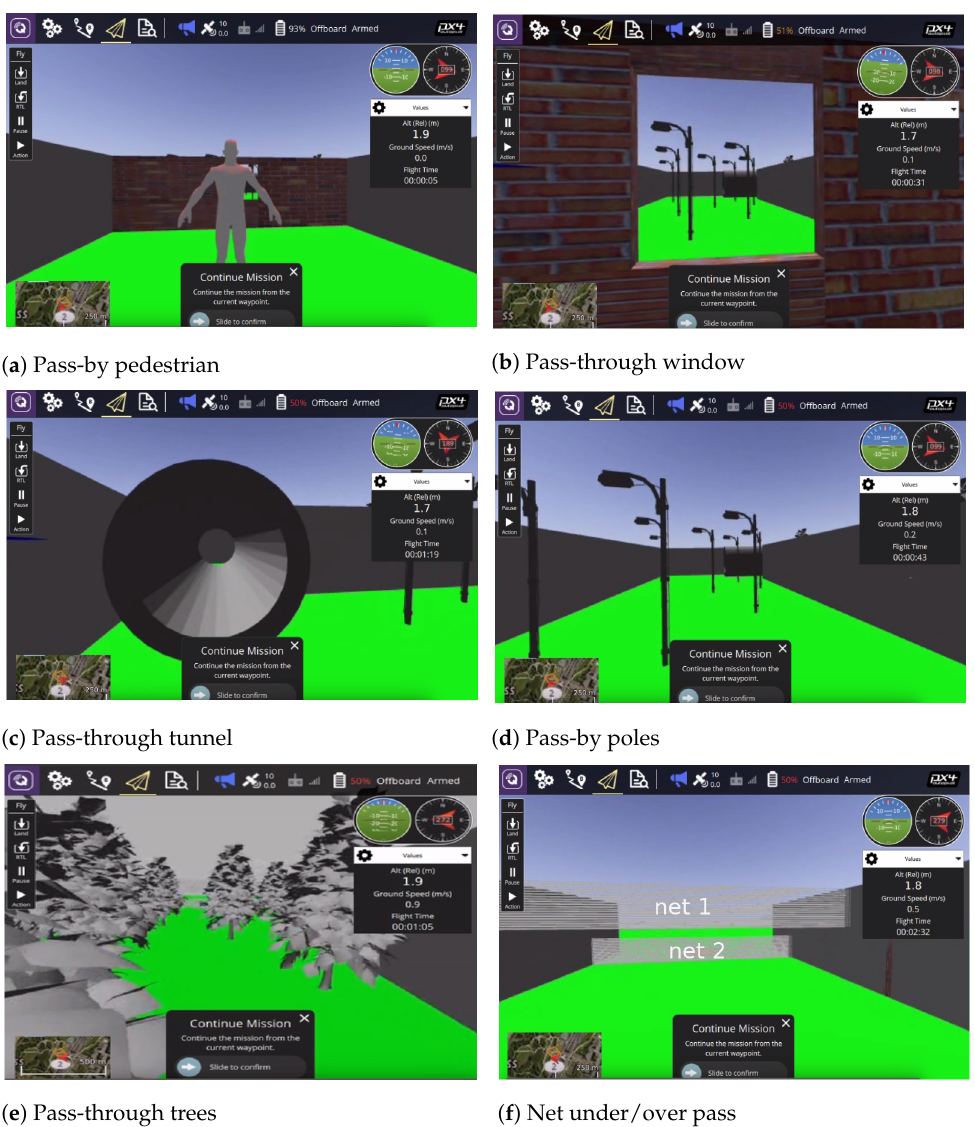
Figure 9. Instant snapshots during obstacle avoidance